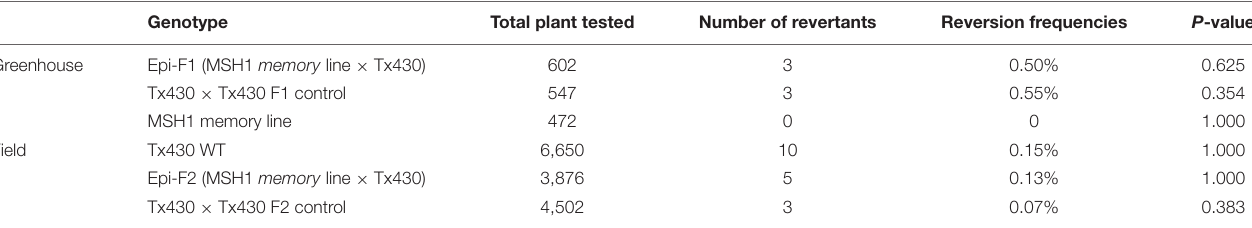
FIGURE 1 | Sorghum dw3 reversion in Tx430. (A) Tx430 plants ( dw3/dw3 ) in the field, with visible a DW3 revertant (red arrow). (B) Stalk internode compaction in the TX430-dwarfed dw3 phenotype (right) compared to a DW3 revertant (left). (C) DW3 revertants and Tx430 wild-type ( dw3/dw3 ) genotypes assayed by PCR. Fragment size (bp) marker lane on left. Dw3 and dw3 alleles were discriminated by the presence of a tandem repeat of 882 bp in exon 5; the wild-type plants showed a major band ( > 1,500 bp). Polymerase chain reaction (PCR) conditions were optimized for amplification of revertant product. (D) MSH1-RNAi transgene-null (memory) plant containing the functional DW3 allele. Under the conditions of this study, DW3 was not detectable in the phenotype of MSH1-RNAi transgene-null (memory) plants. TABLE 1 | Evaluation of dw3 reversion frequencies in msh1 -derived genotypes and isogenic wild-type Tx430. Genotype Total plant tested Number of revertants Reversion frequencies P